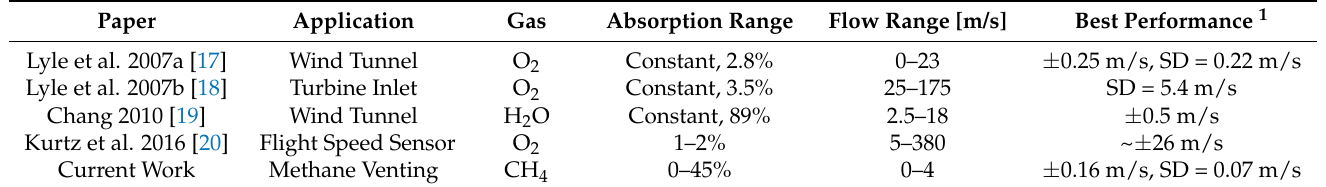
Table 1. Comparison of WMS sensors for subsonic gaseous flows, including the current work.